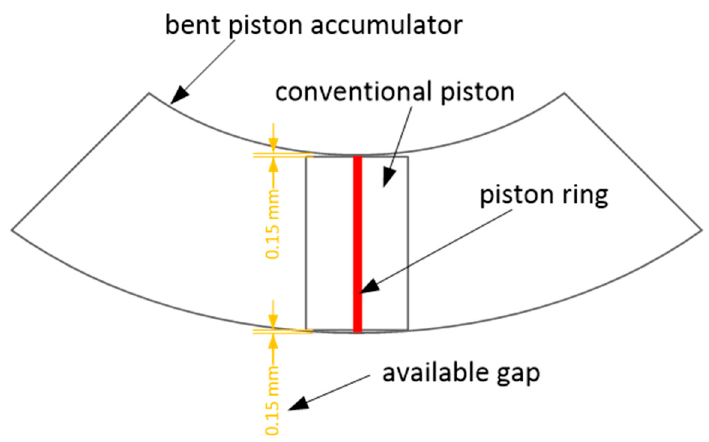
Figure 5. Illustration of a bent piston accumulator in the side view (not to scale).